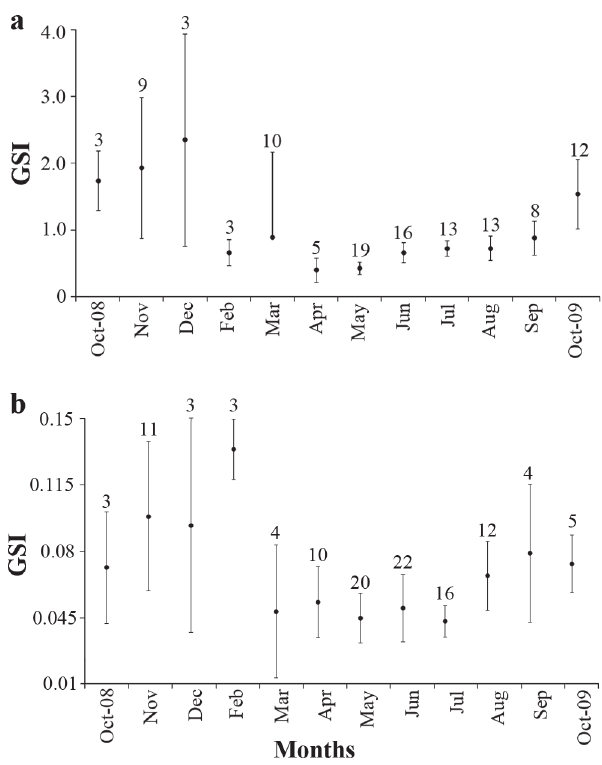
Fig. 5. Monthly variation of the mean GSI of females ( a ) and males ( b ) of Etropus crossotus in the shallow infralittoral areas of the Paranaguá Estuarine Complex. GSI = gonadosomatic index. The error bars correspond to the standard deviation. The numbers indicated above the error bars refer to absolute frequency.